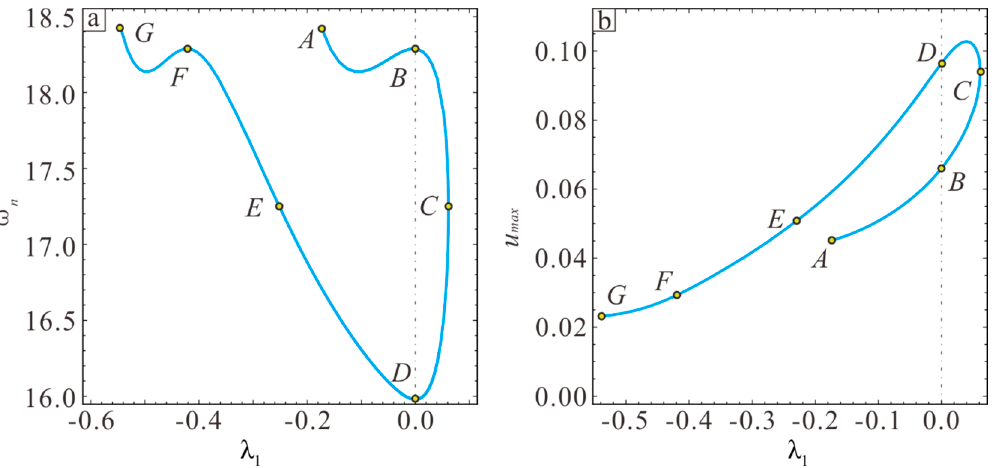
Figure 12. Frequency response curves for A , B , C , D , E and F cases: ( a ) the case of D ; ( b ) the cases of A and G ; ( c ) the cases of B and G ; ( d ) the cases of C and E .